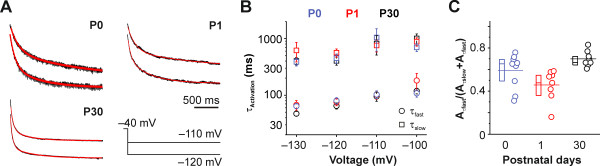
Activation kinetics of pharmacologically isolatedIhslightly accelerated with age. (A) Representative Ih activation traces of P0, P1 and P30 neurons in response to hyperpolarizing step potentials of −110 mV and −120 mV (voltage protocol: bottom right). The traces are depicted from approximately 20 milliseconds after step onset (skipping the capacitive relaxation) to the end of the 2-second step. Red lines are double exponential fits. Note that current amplitudes have been normalized for comparability. (B) Activation time constants speeded up only marginally from P0 to P30, when measured somatically. Displayed are fast (circles) and slow (squares) time constants of a double exponential fit. Ages in (B) and (C) are coded in colors: blue - P0, red - P1, black - P30. (C) Population data and 25 to 75% box plots on the amplitude contribution of fast-activating Ih components to the whole current (n = 8 - 9) for the studied time points. Solid lines through boxes and data represent means.